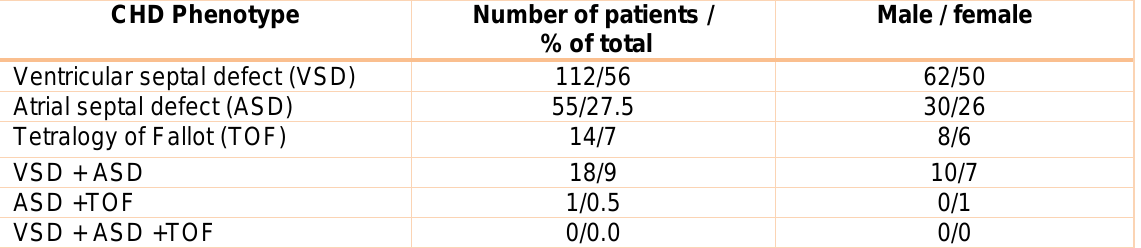
Table 1: Clinical characteristics of unrelated non-syndromic CHD patients